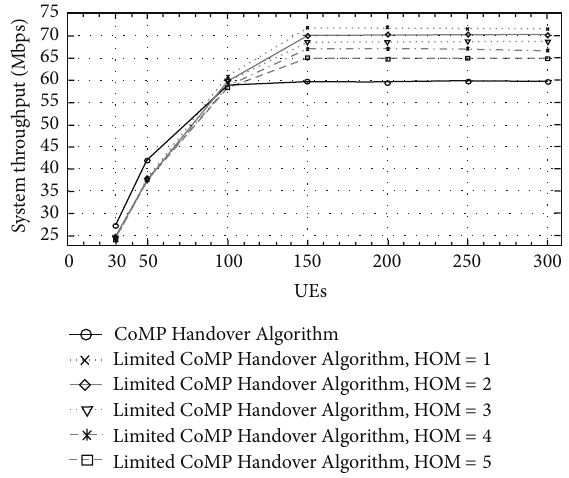
Figure 8: System Throughput of CoMP Handover Algorithm and Limited CoMP Handover Algorithm in LTE-A.